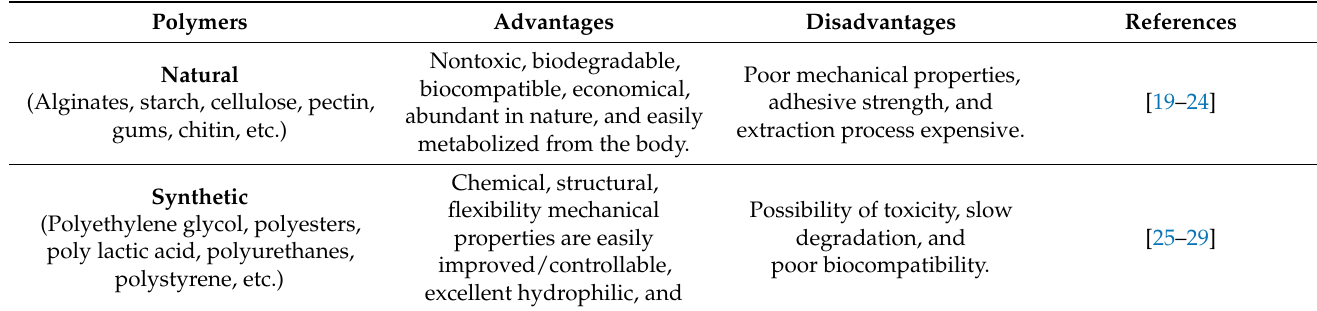
Table 1. Natural and synthetic polymers’ advantages and